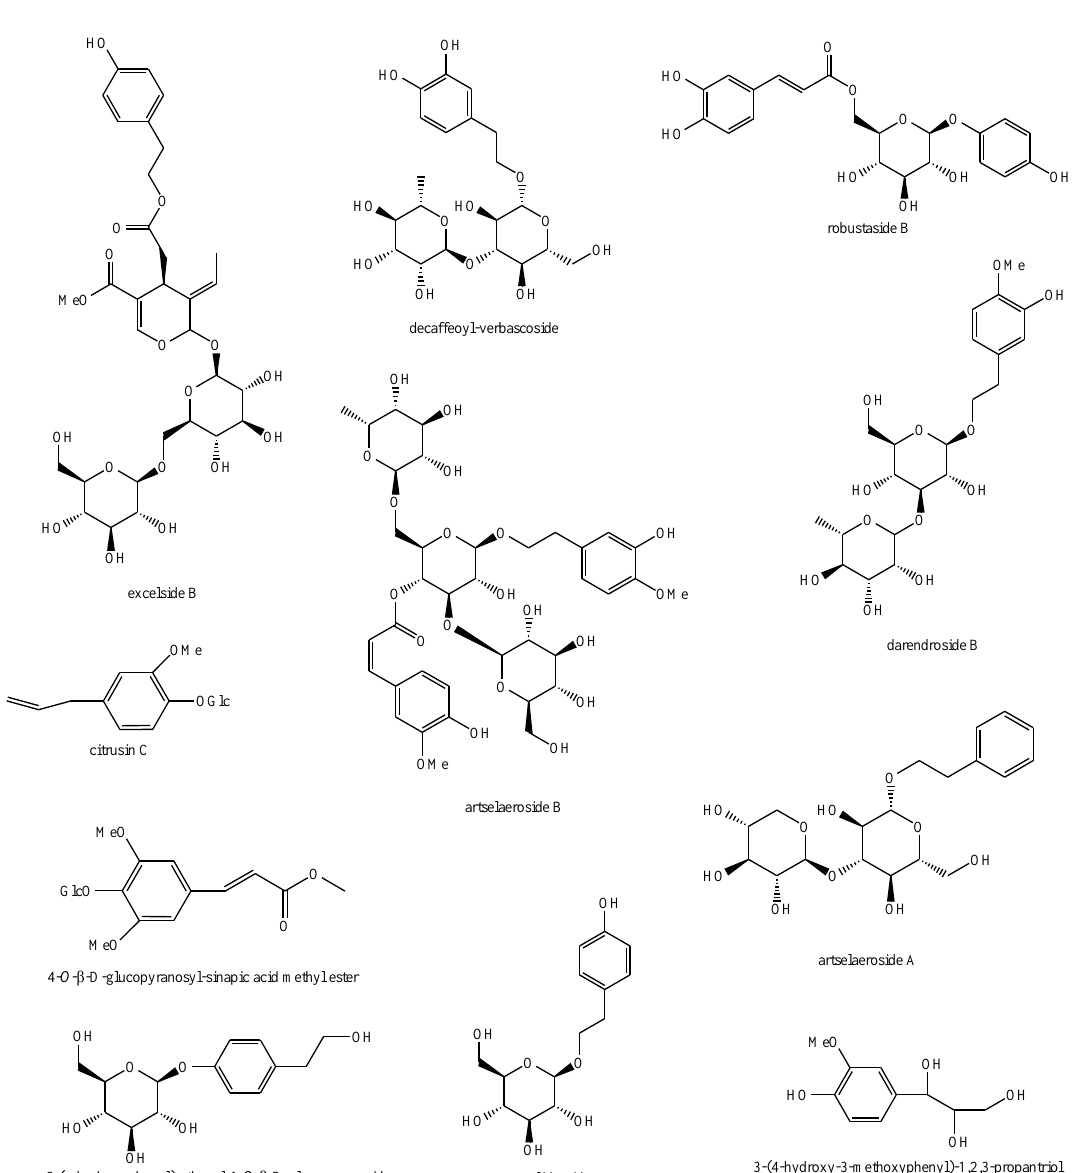
Figure 12. Phenylethanoid glycosides identified in Pedicularis species—part 3.